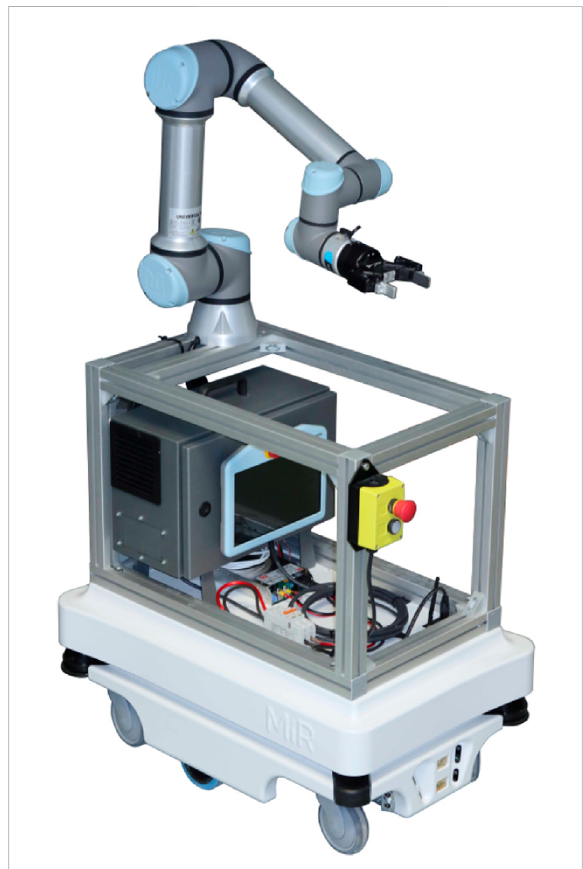
FIGURE 9 MiR100 mobile platform with UR5e manipulator. As a